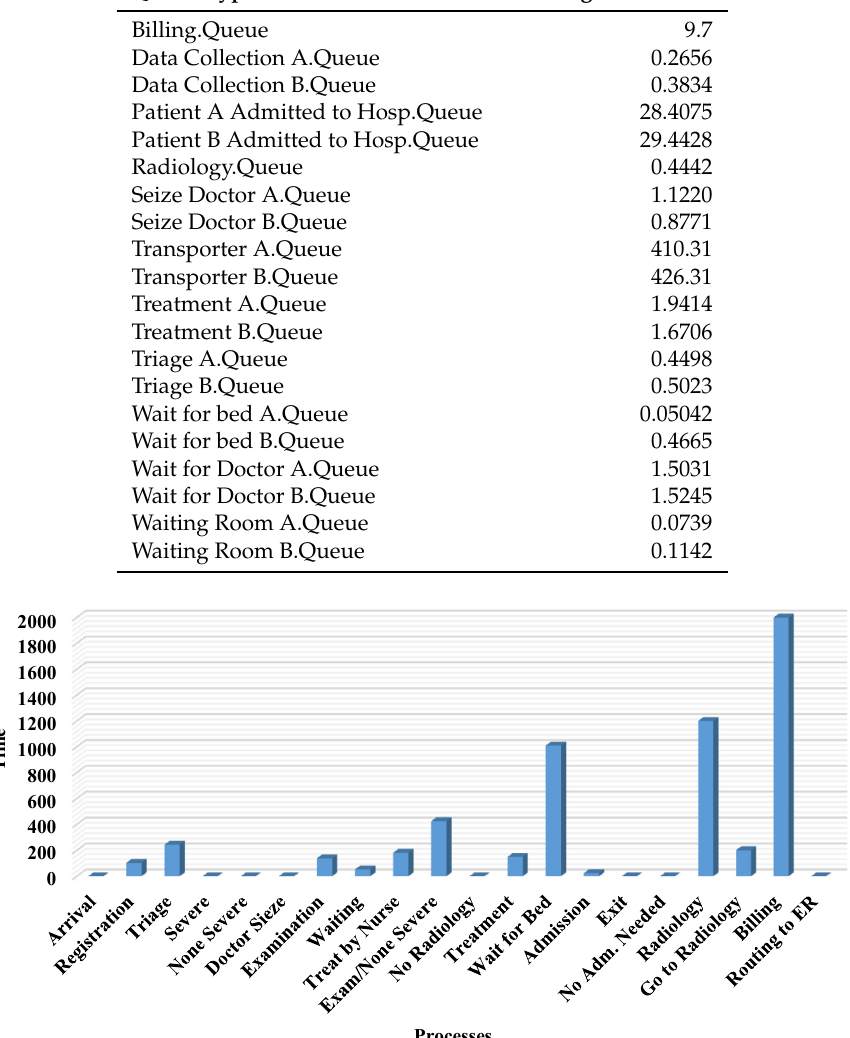
Figure 11. Units’ service